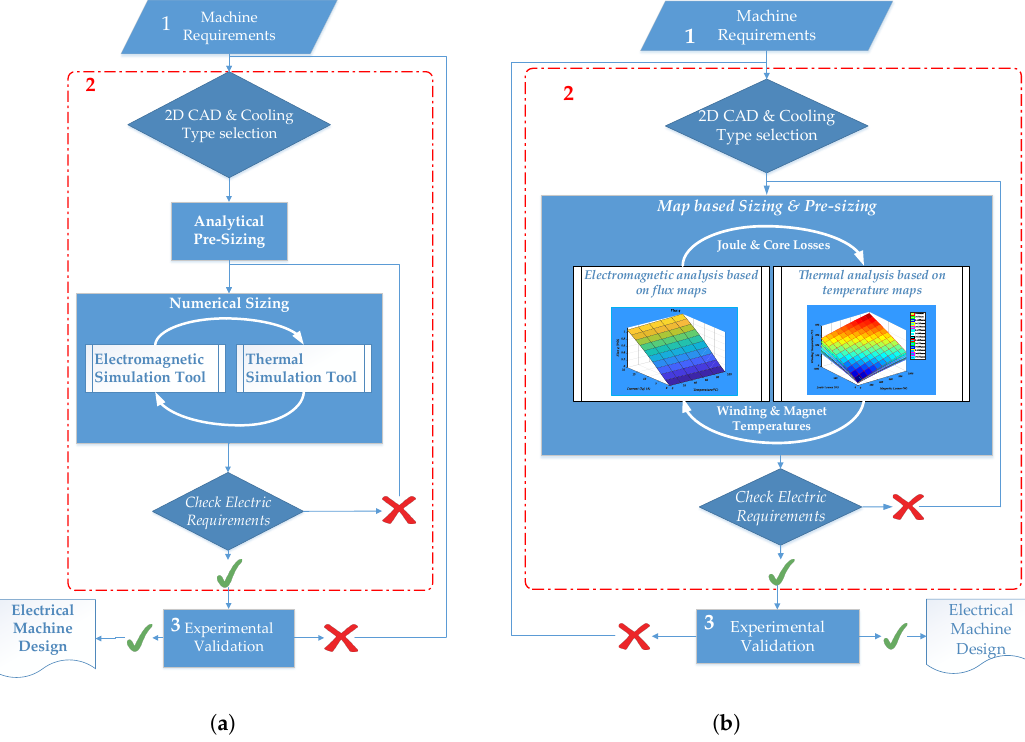
Figure 1. Description of the sizing methodology using multi-physics tool. ( a ) classical Method; ( b ) integration of the sizing multi-physics tool in the classical